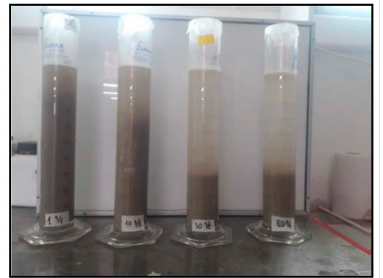
Figure 1. Sedimentation tests with Magnafloc